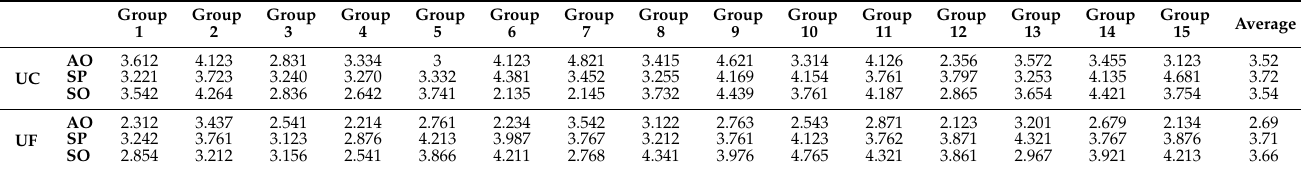
Table 16. UC and UF survey answers of perception of